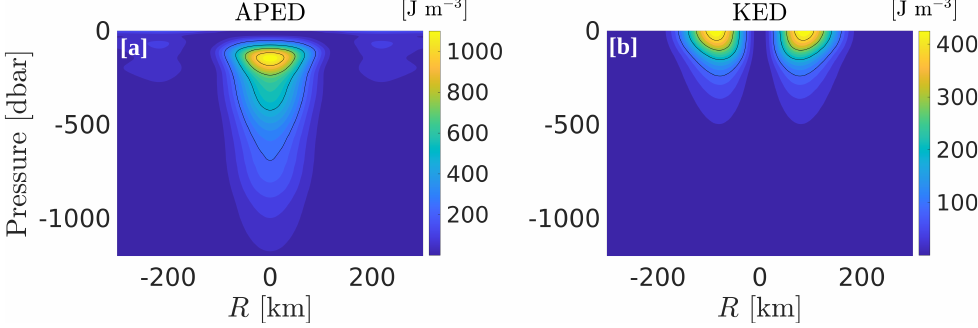
Figure 14. Same as Figure 11 for available potential energy density ( a ), and kinetic energy density ( b